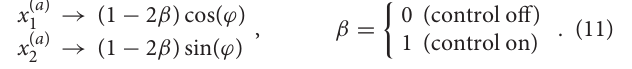
Frontiers in Neurorobotics |